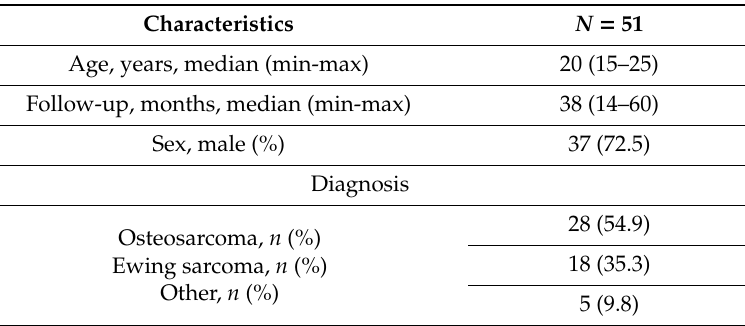
Figure 1. Enrolment process. Table 1. Patient characteristics.